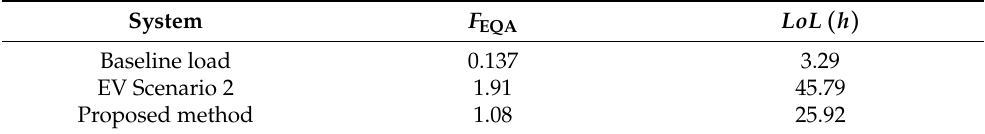
Table 4. F EQA and LoL in scenario 2.